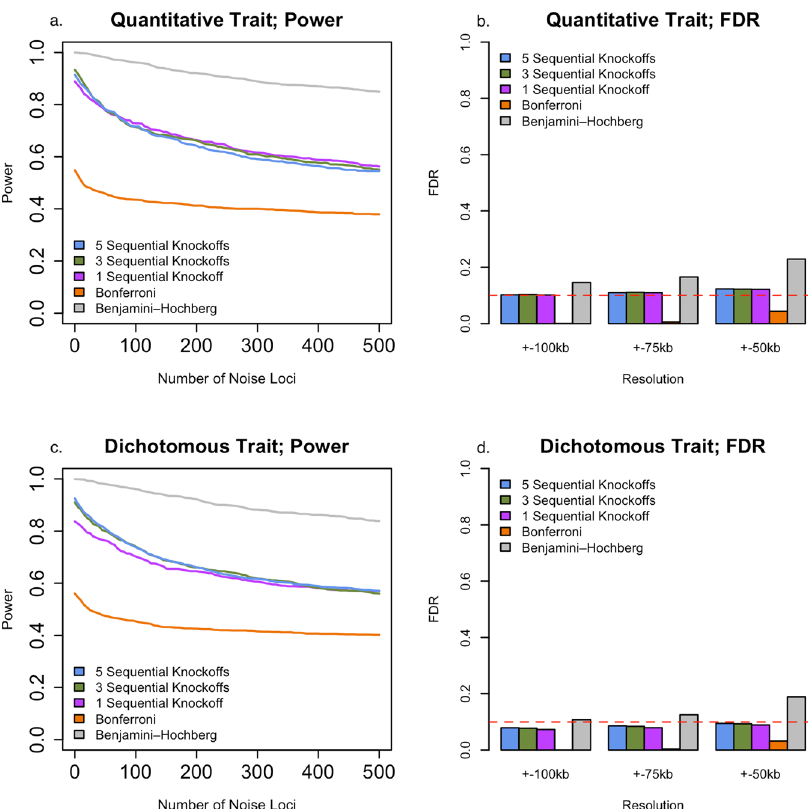
Fig. 3 Genome-wide power and false discovery rate (FDR) simulations studies in the presence of multiple causal loci. a , c Empirical power for different types of traits (quantitative and dichotomous), de fi ned as the average proportion of 200 kb causal loci being identi fi ed at target FDR 0.1. b , d Empirical FDR for different types of traits (quantitative and dichotomous) at different resolutions, de fi ned as the proportion of signi fi cant windows (target FDR 0.1) ± 100/ 75/50 kb away from the causal windows. The empirical power and FDR have averaged over 100 replicates. Source data are provided as a Source Data fi